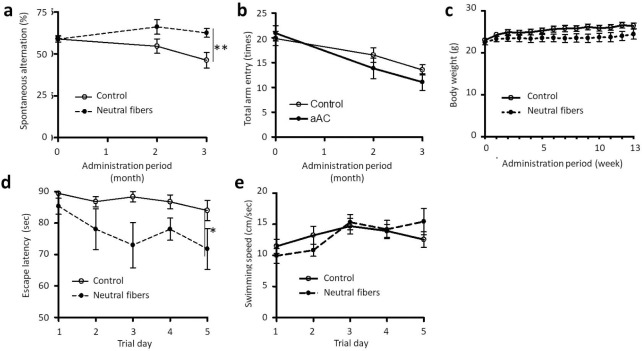
Beneficial effects of αAC nanofiber on cognitive dysfunction in APPswe/PS1dE9 transgenic AD model mice.(a) Percentage of spontaneous alternation behavior in the Y-maze test. **P = 0.005, two-way analysis of variance (ANOVA). The neutral αAC nanofibers were intranasal administered to female mice at ca. 1.5 mg/kg twice weekly for 8 weeks. The open and closed circle plots indicate the vehicle (n = 13) and neutral αAC nanofiber group (n = 13), respectively. (b) The change in total number of arm entry in the Y-maze test. (c) The change in body weight of the AD model mice. (d) Escape latency in the Morris water maze test. **P = 0.007, two-way ANOVA. Mean ± SEM, n = 13. (e) Swimming speed of the AD model mice in the Morris water maze test.